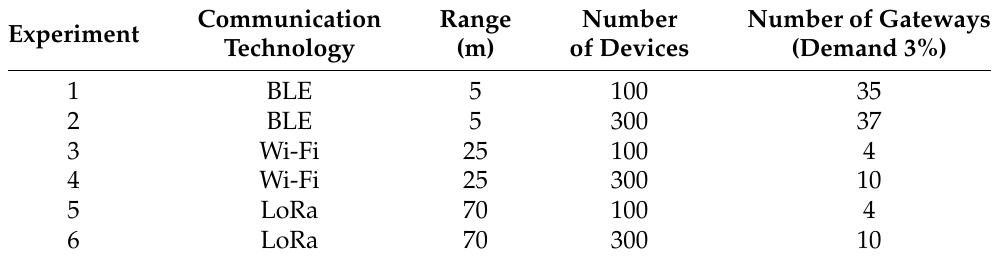
Table 16. The parameters that were applied in the experiments.